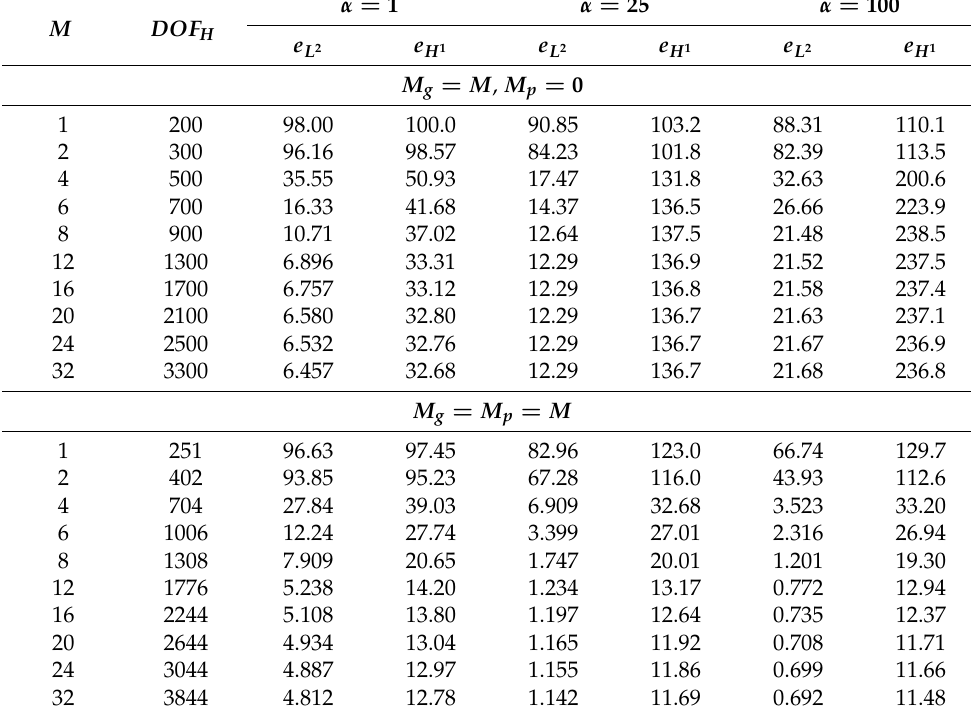
Table 2. Elliptic problem with α = 1,25, and 100. Case 2 (non-homogeneous boundary conditions). Relative L 2 and H 1 error in %. DOF h = 85,230.